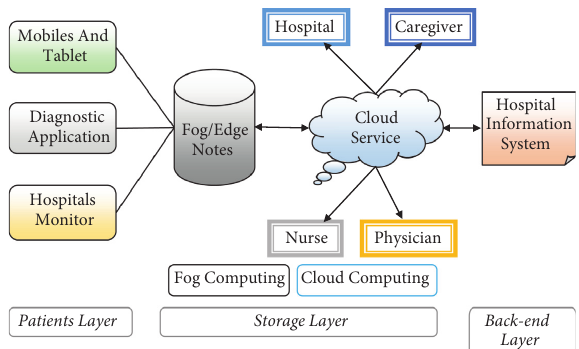
Figure 1: General architecture of